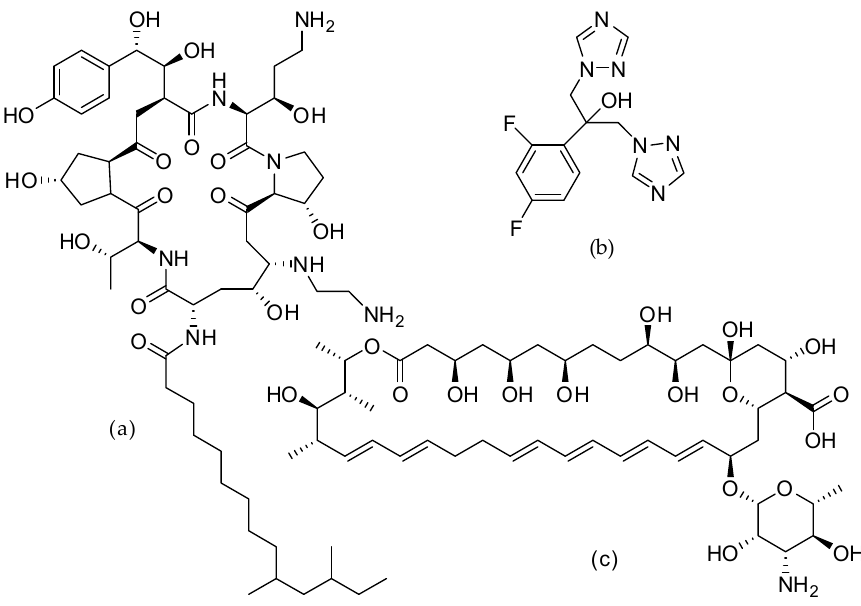
Figure 1. Representative antifungal drugs from several classes. ( a ) Caspofungin; ( b ) Fluconazole; ( c ) Nystatin.